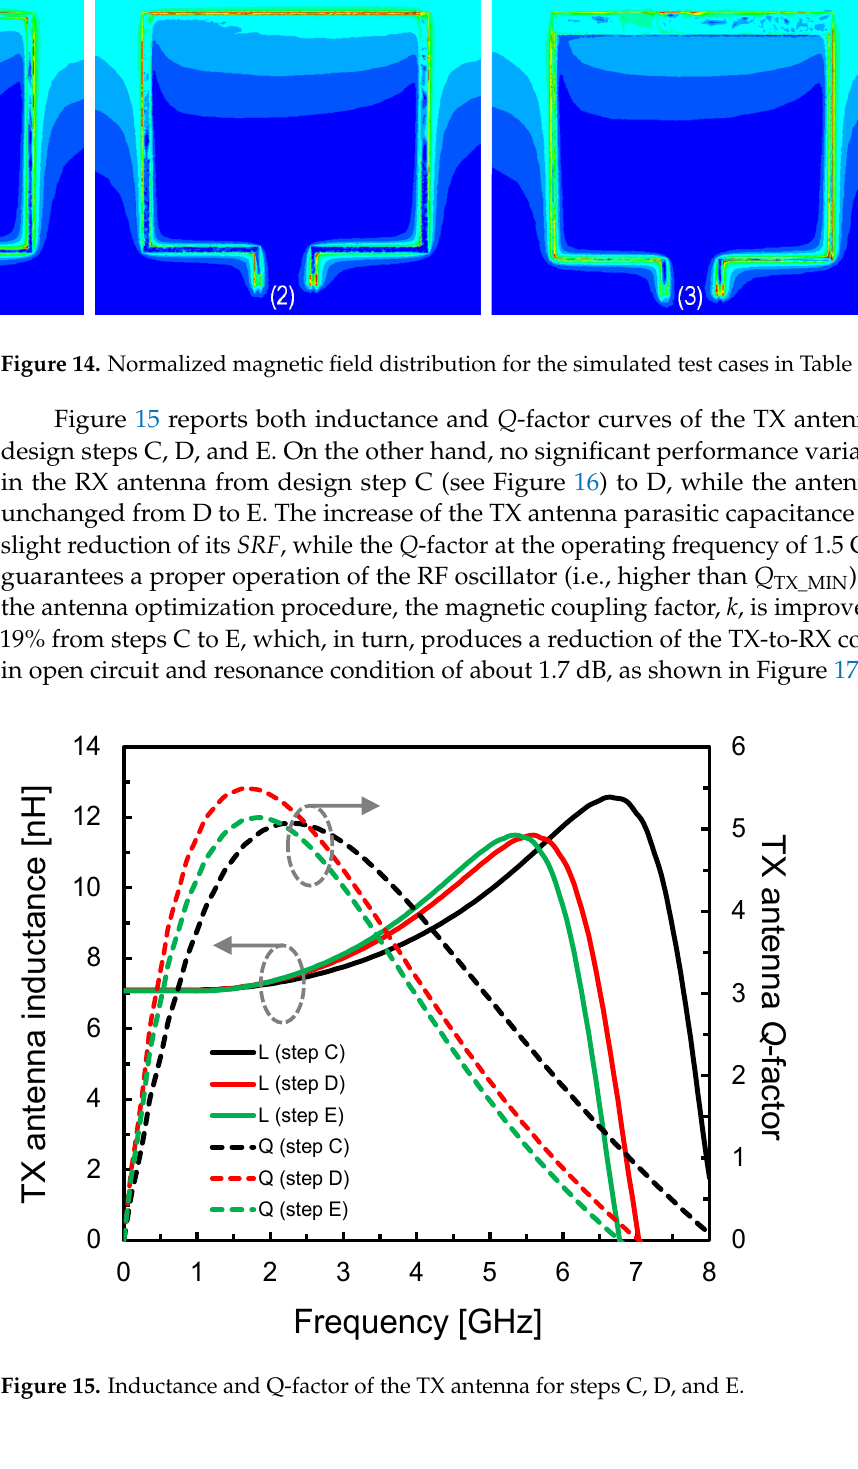
Figure 16. Inductance and Q -factor of the RX antenna for step C.